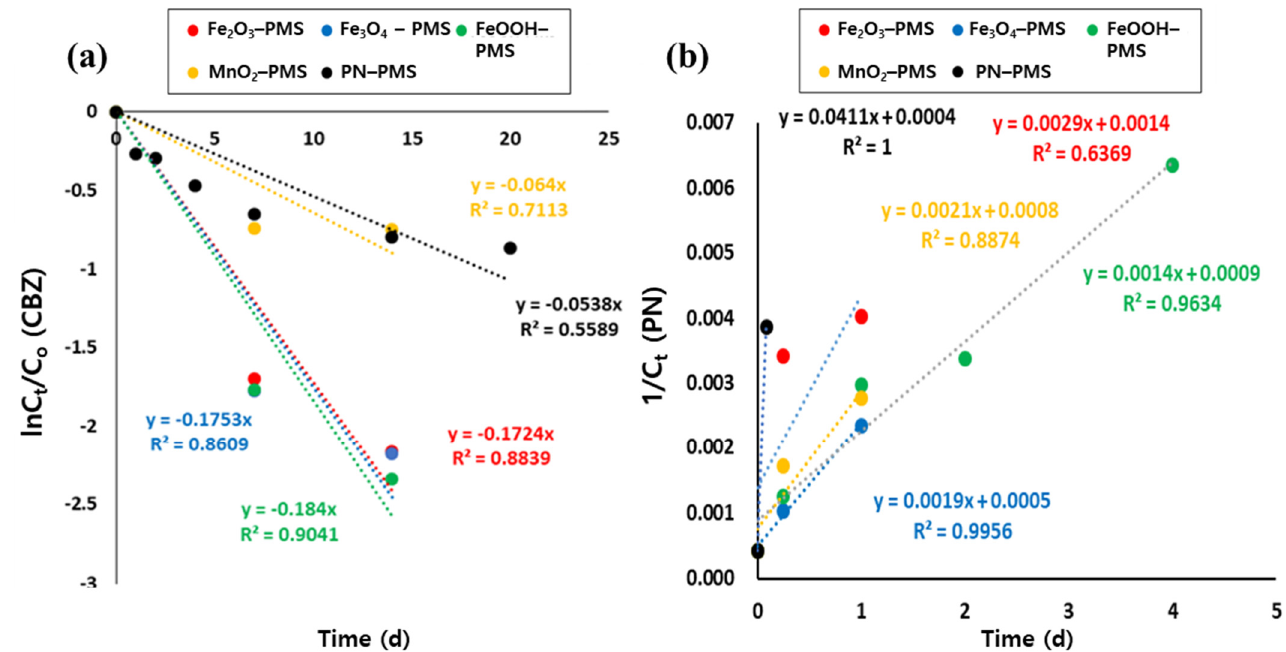
Figure 2. The rates of CBZ and phenol (PN) decomposition by PMS oxidant in the presence of different metal oxides ( a ) CBZ decomposition and ( b ) PN decomposition ([CBZ] = 10 µM, [PN] = 10 µM, [PMS] = 200 µM, [metal oxide = 0.1 g/L, [borate buffer solution] = 18.75 mM, [pH] = 7.5~8.0, sampling time = 0, 7, 14 and 21 d for CBZ decomposition, 0, 0.25, 1, 2, 4 and 7 d for PN decomposition).